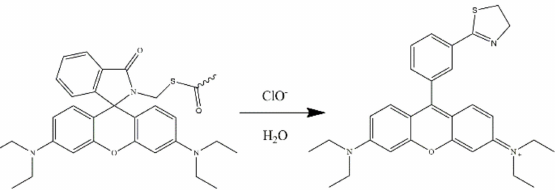
Figure 48. The proposed sensing mechanism of SRh (Table 3, No. 11) with ClO − [100].